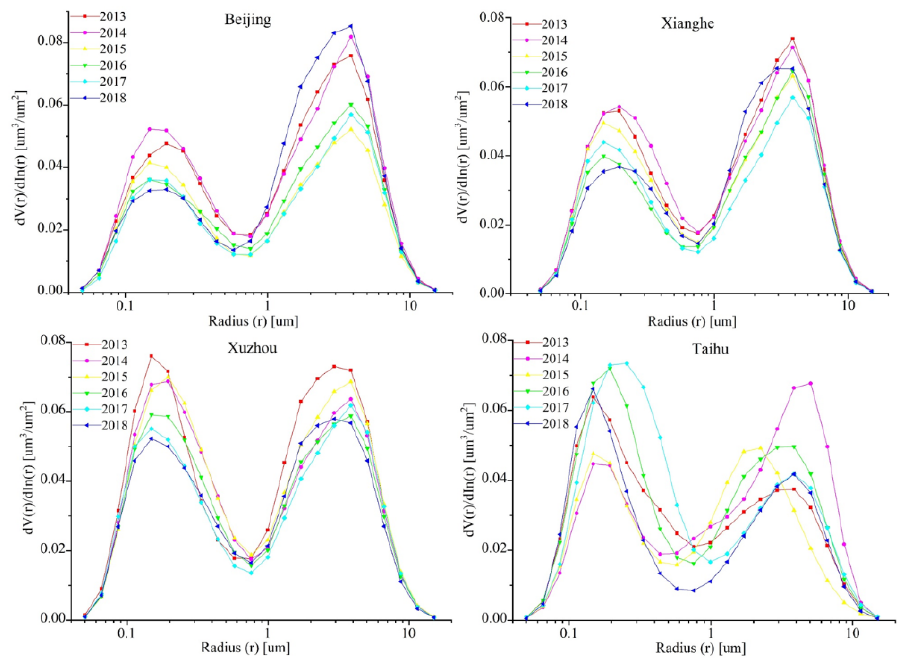
Figure 6. Annual mean of AERONET volume size distribution during 2013–2018.